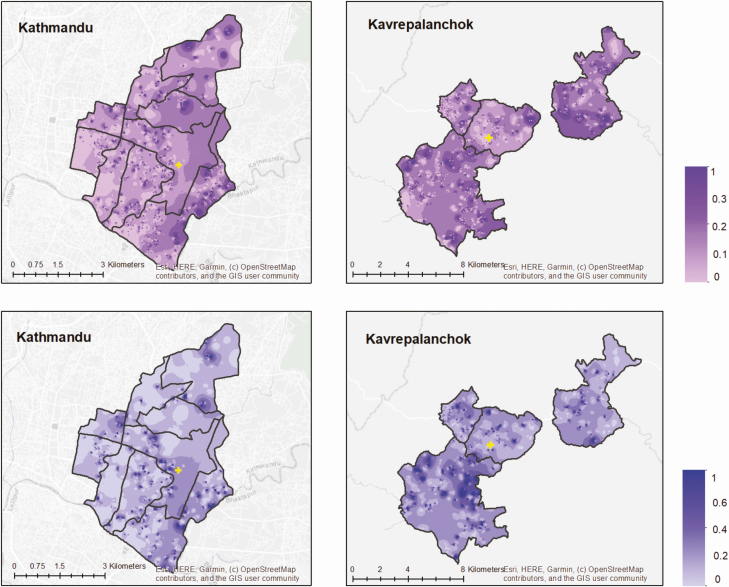
Proportion of individuals with fever in the past 8 weeks (top) and hospitalized for fever in the past year (bottom) for Kathmandu and Kavrepalanchok. Yellow crosses denote the location of study surveillance hospitals.